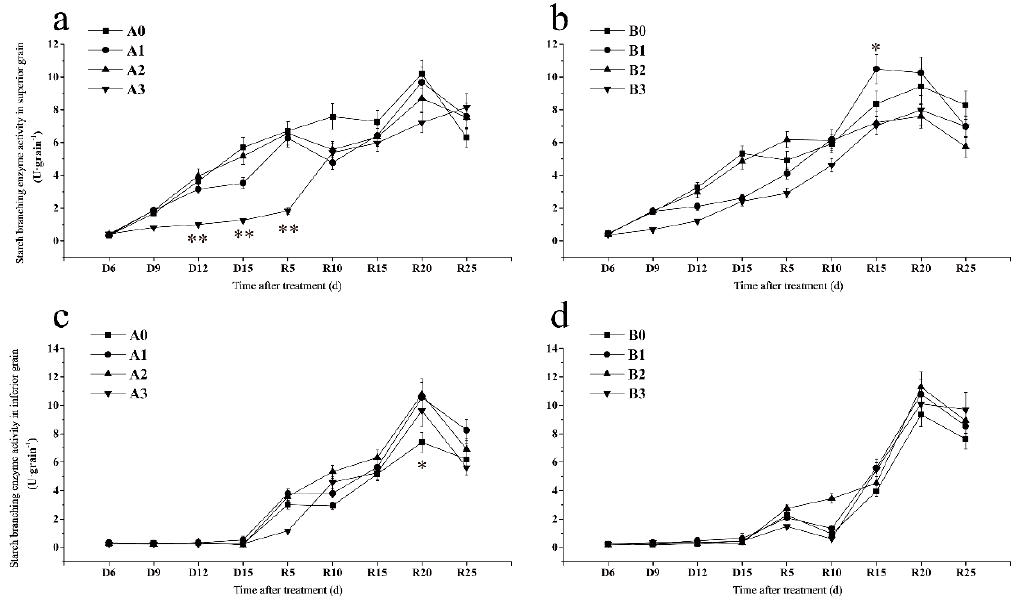
Figure 5. Effects of drought stress at the jointing–booting stage on the key enzymes for starch synthesis of superior ( a , b ) and inferior ( c , d ) grains in growth period overlapping rice. *, ** represent significance at p < 0.05 and p < 0.01, respectively.